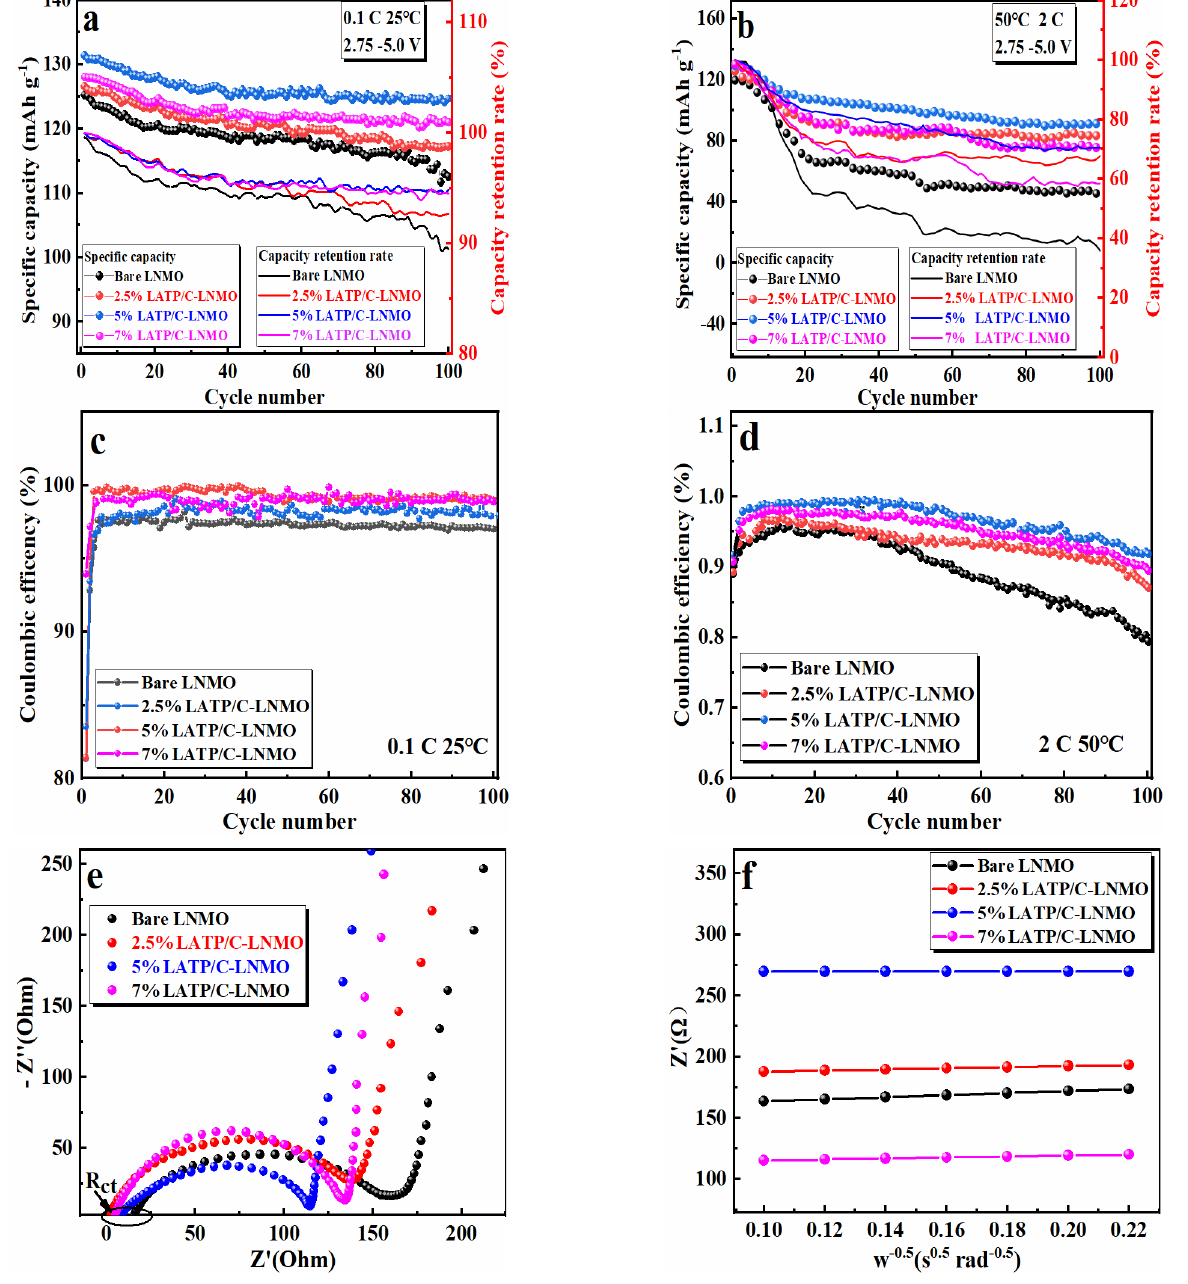
Figure 6. The cyclic performance of the bare and LATP/Ccoated LNMO composite electrode for 100 cycles: ( a , c ) at 0.1 C and room temperature; ( b , d ) at 2 C rate and 50 °C, the EIS plots ( e ) and Z’ vs. ω −0.5 plots ( f ) of pristine LNMO and LATP/C-LNMO.